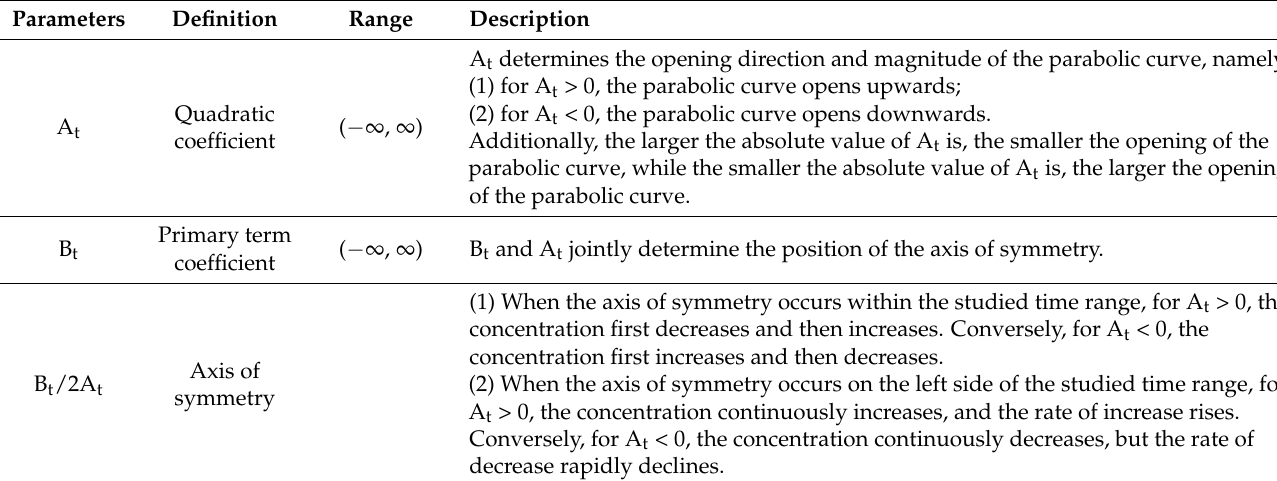
Table 1. Parameters and their descriptions in the improved sine function